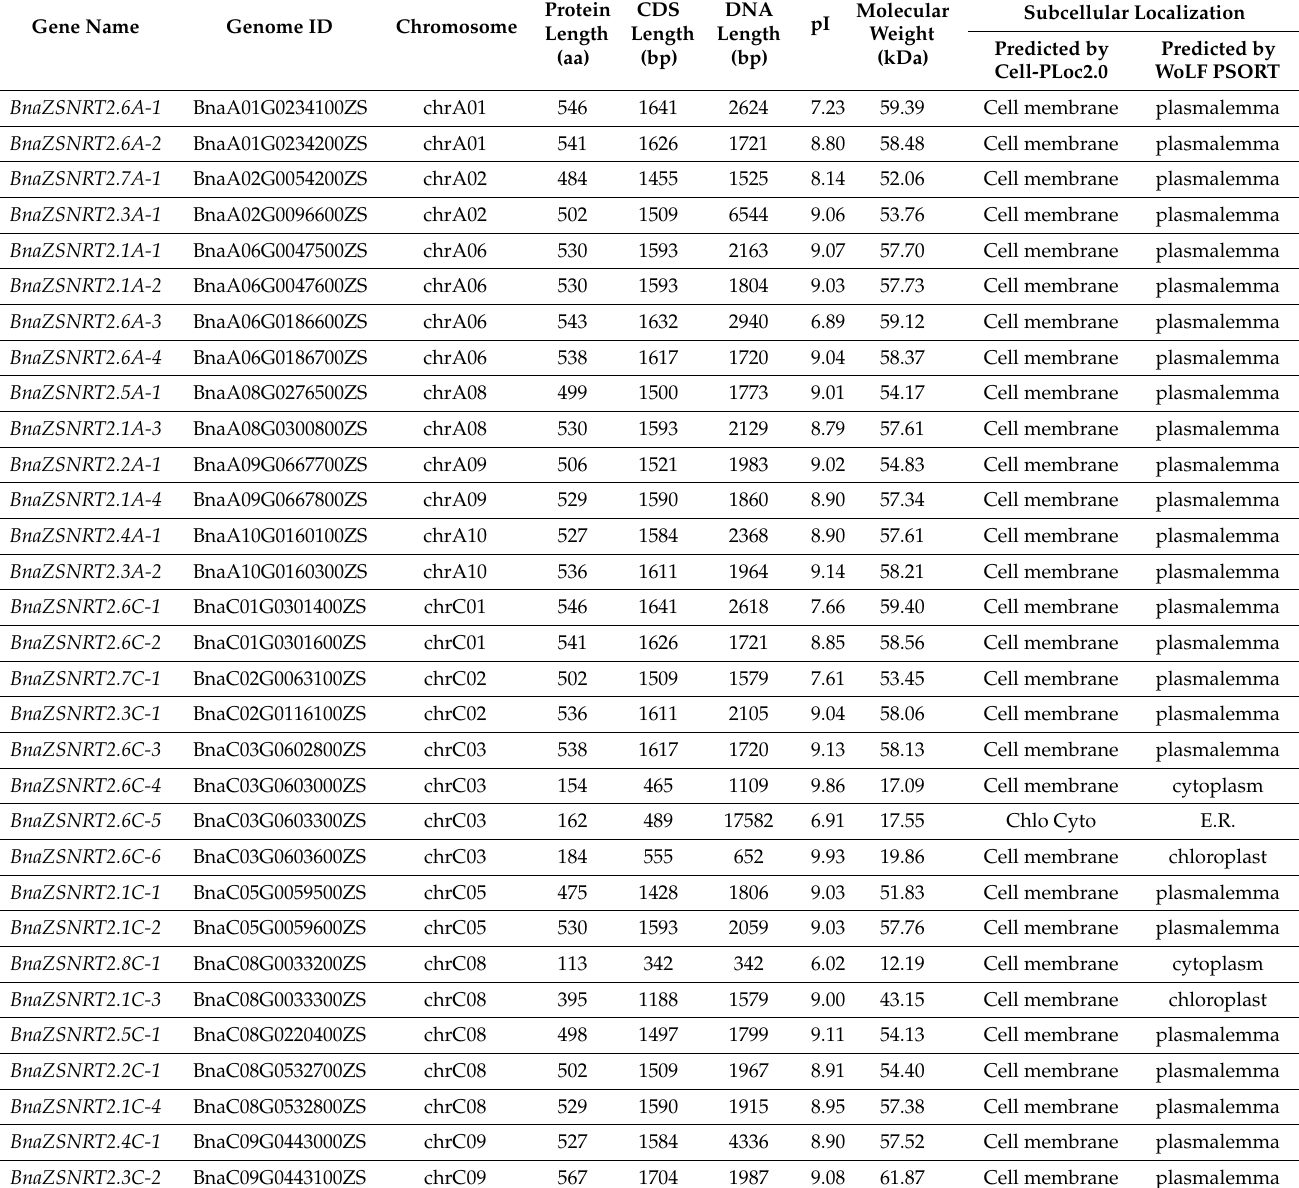
Table 1. Features of the 31 NRT2 genes (BnaZSNRT2s) identified in Brassica napus Zhongshuang 11 (ZS11)